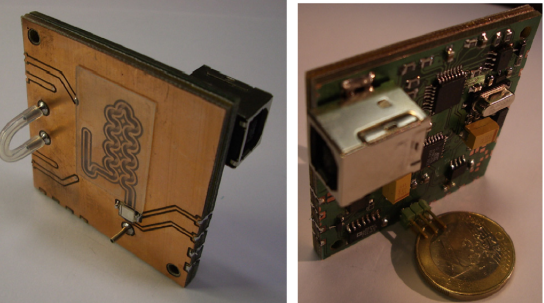
Figure 14. The first lab-on-PCB reported by Stefan Gassmann et al. (reprinted from [11], copyright (2007), with permission from